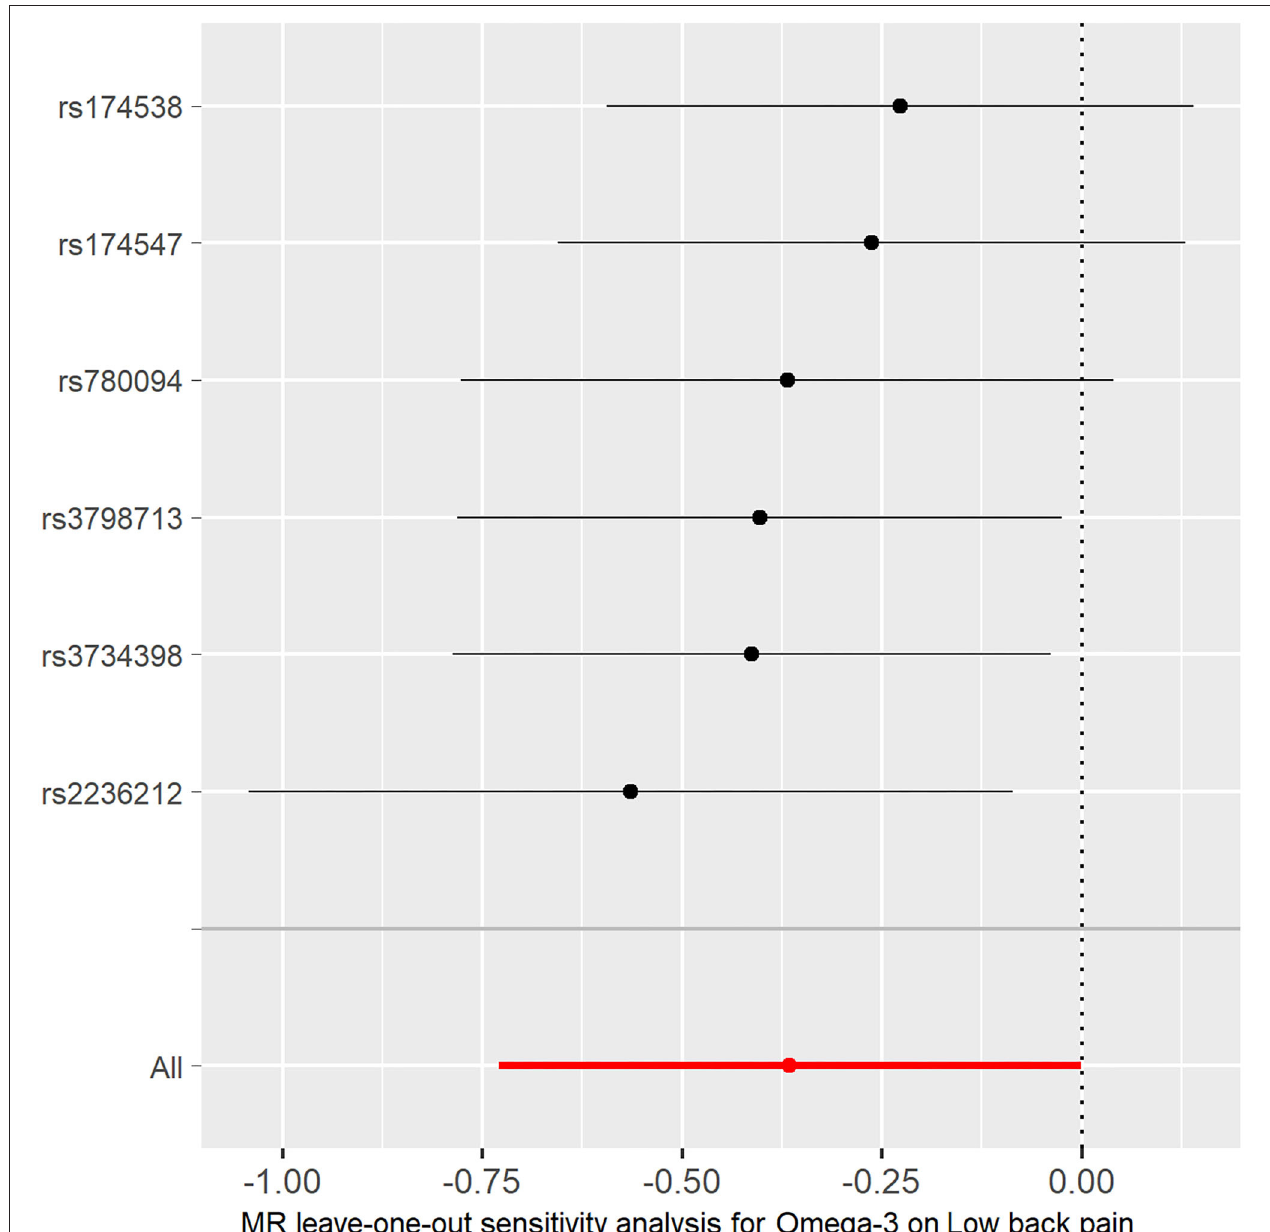
FIGURE 4 | MR leave-one-out sensitivity analysis for the effect of omega-3 SNPs on low back pain. The x-axis shows MR leave-one-out sensitivity analysis for omega-3 on low back pain. The y-axis shows the analysis for the effect of leave-one-out of SNPs on low back